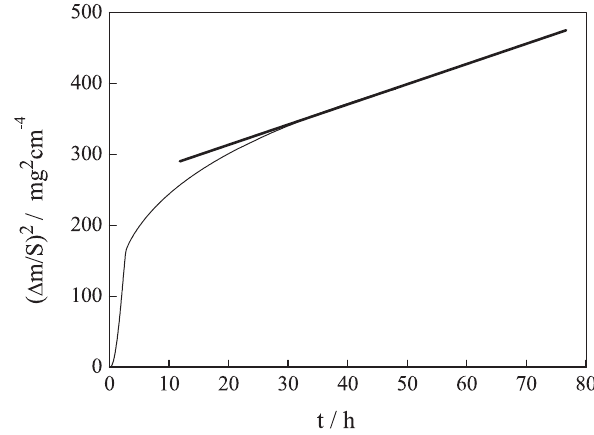
Fig. 8: The sulphidation kinetics of NiS, resulting in the formation of NiS 2 .